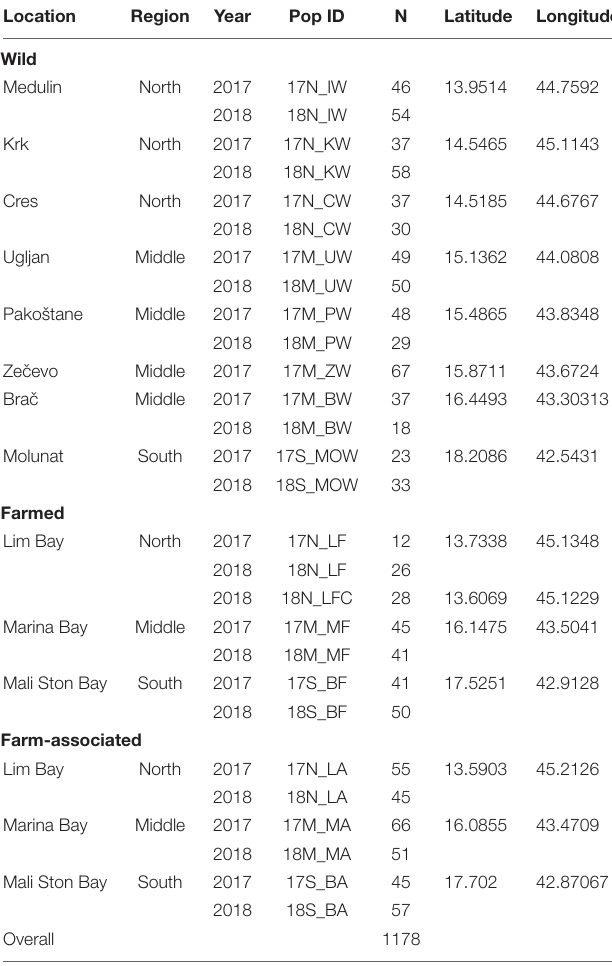
TABLE 1 | Information of sampling locations, regions, years and codes, along with the number of individual European flat oyster that were genetically assayed with 12 putatively neutral